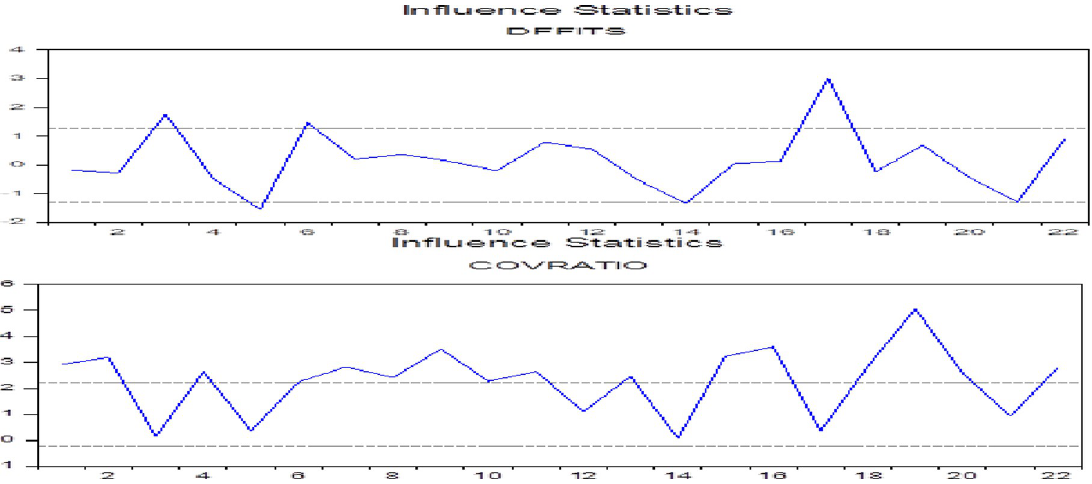
Fig 1. Influence statistic: Success of fiscal adjustment model. The impacts of individual data points or groups of data points on a statistical study are measured using influence statistics. The spikes in the graphs based on the two influence measurements indicate outliers in the